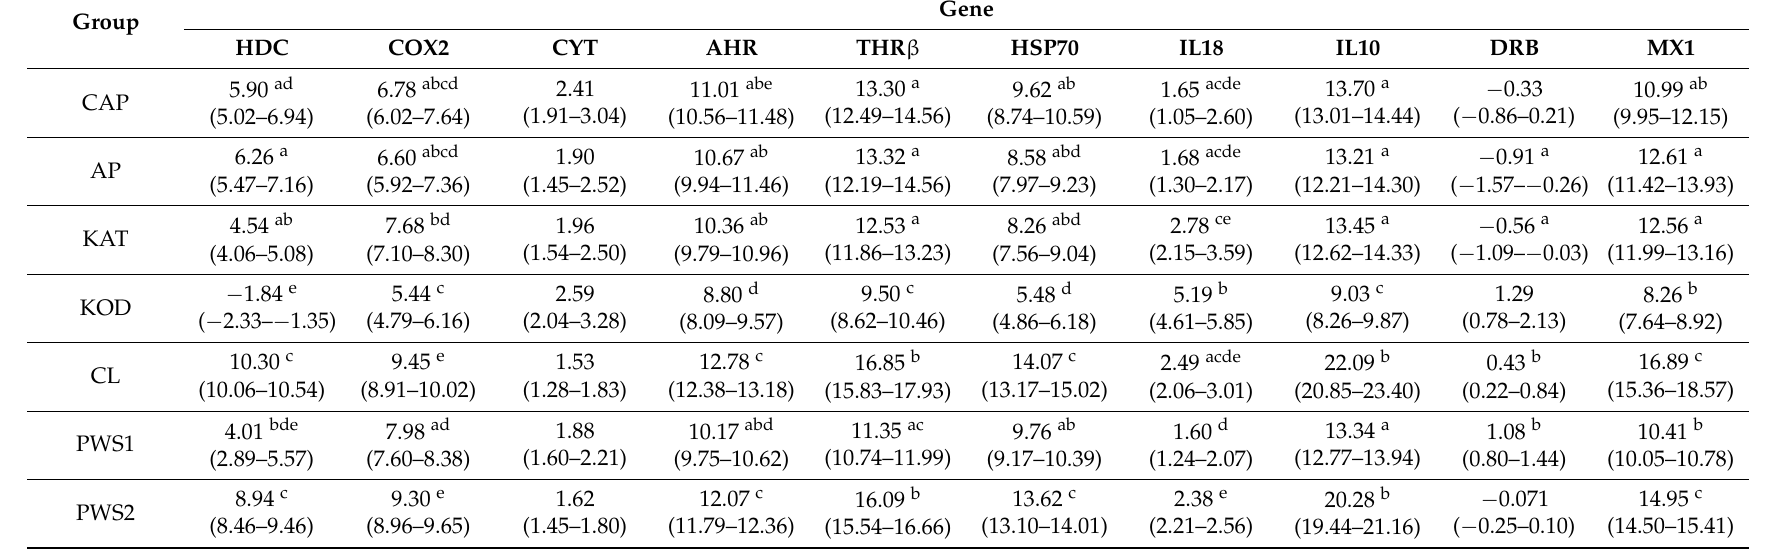
Table 2. Geometric mean (normalized to the S9 housekeeping gene in each animal) cycle threshold (C T ) transcription values (and 95% confidence intervals) for targeted genes (see Table 1) in sea otters sampled at the Alaska Peninsula (AP), Katmai (KAT), Kodiak (KOD), Clam Lagoon (CL), Prince William Sound 2006–2008 (PWS1), Prince William Sound 2010–2012 (PWS2) and clinically normal captive otters (CAP). Letter (a,b,c,d) differences denote significant differences among populations (Kruskal–Wallis with Dunns’ multiple comparison); lack of a letter (a,b,c,d) denotes no significant difference from any other group. Note that the smaller the mean value, the higher thelevel of